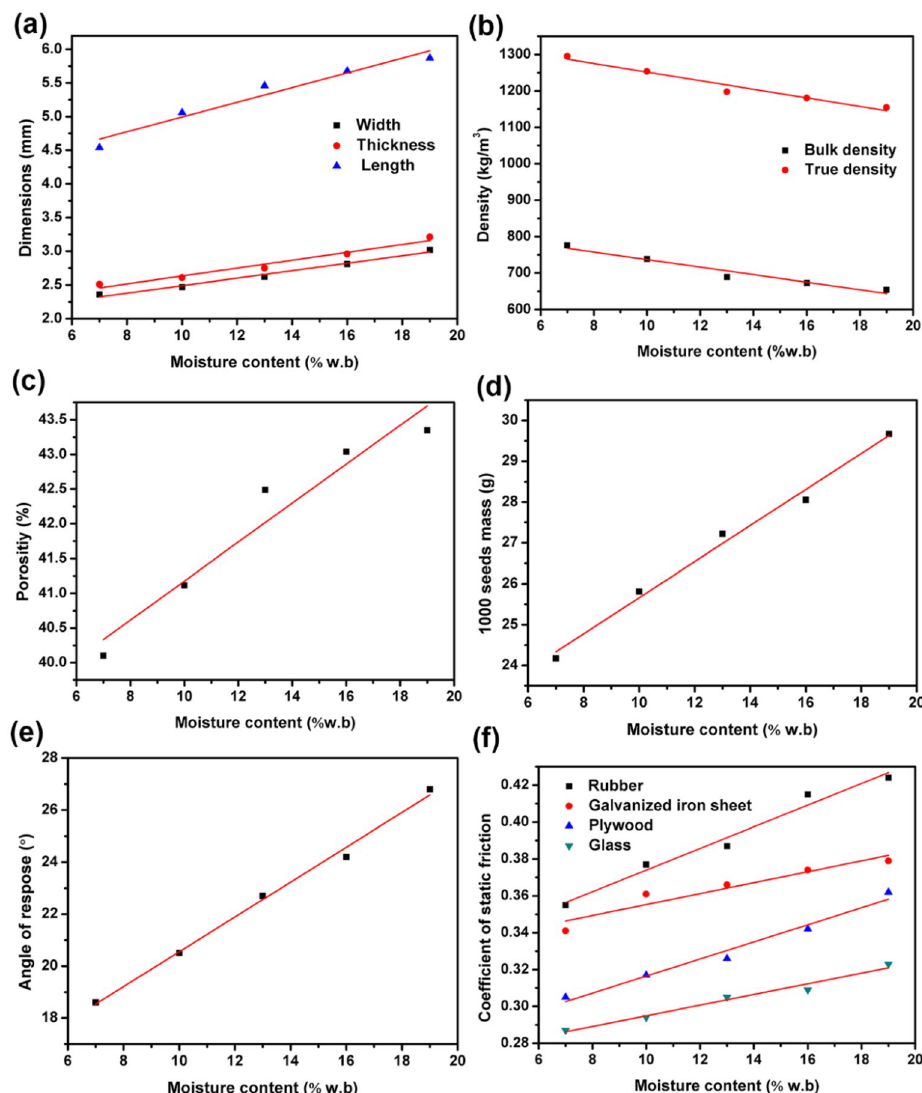
Figure 2. ( a ) Dimensions of Cassia tora L. seeds, ( b ) bulk and true densities, ( c ) porosity, ( d ) 1000 seeds mass, ( e ) angle of repose, ( f ) friction coefficient against four different material surfaces (rubber, galvanized iron sheet, plywood and glass, respectively) of Cassia tora L. seeds effected by moisture content of Cassia tora L.